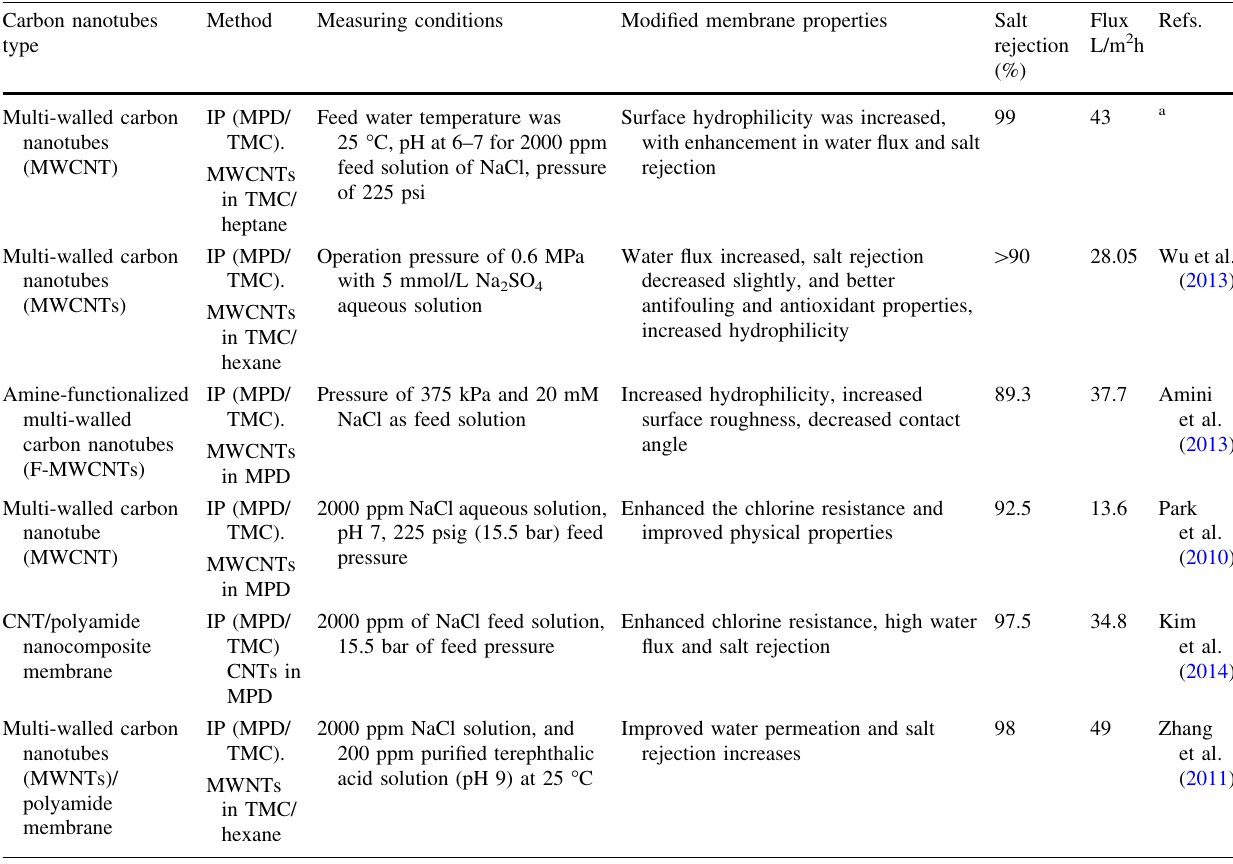
Table 1 A brief summary of previous studies Carbon nanotubes